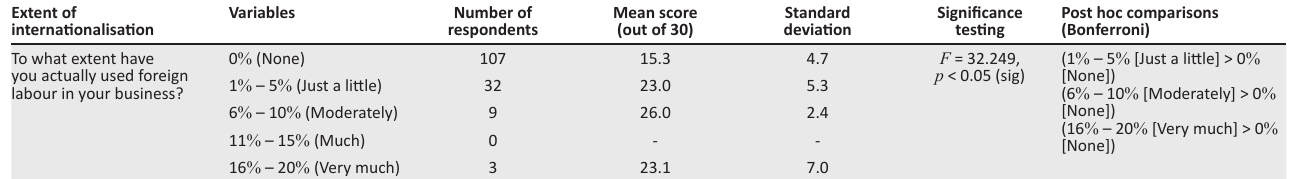
TABLE 4: Comparison of mean scores on the ‘importance and/or relevance of internationalisation of labour’ index. Extent of Variables Number of Mean score internationalisation respondents (out of